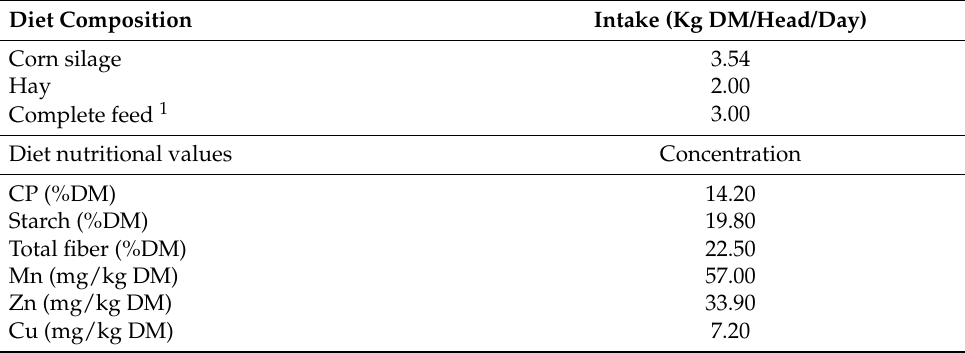
Table 2. Composition and chemical analysis of donor animal